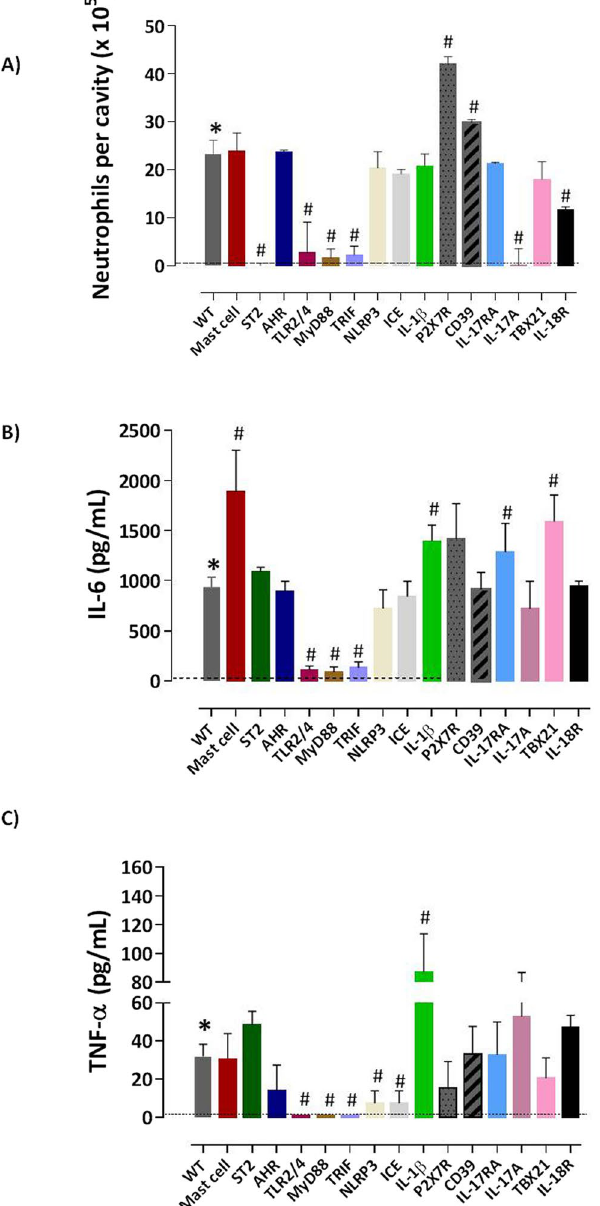
Figure 5. Innate signals regulate the neutrophilia, IL-6 and TNF- α in stingray venom inflammation. Stingray venom (300 μ g/ml) in 500 μ l or sterile saline were injected i.p. into C57BL/6 WT or mast cell-deficient Kit Wsh/ Wsh, ST2 − / − , and AHR − / − ; or in TLR2/4 − / − , MyD88 − / − and TRIF − / − ; or in NLRP3 − / − , ICE − / − and IL-1 β − / − ; or in P2RX7 − / − and CD39 − / − ; or in IL-17A − / − and IL-17RA − / − , or in TBX21 − / − and IL-18R − / − . Two hours later, peritoneal cells were harvested and aliquots applied on glass slides were stained and neutrophils ( A ) were counted in a proportion of total cells. IL-6 ( B ) and TNF- α ( C ) were analyzed by CBA in the peritoneal exudates of C57BL/6 WT or deficient mice. Results represent mean ± SEM. Pooled results of two independent experiments are shown. * p < 0.05 compared with the control-group (dotted line) and # p < 0.05 compared to WT mice injected with ray